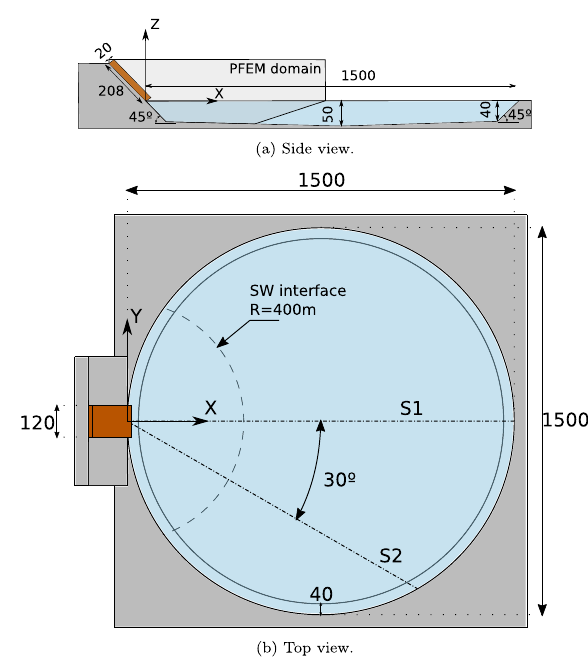
Fig. 12 Landslide in a representative lake. Side and top view of the geometry. Dimensions in m